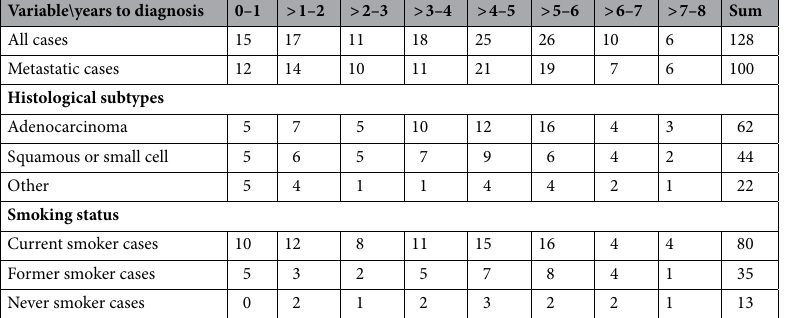
(Table S4). The gene with the lowest p-value for a non-linear trend in the absolute case–control differences in gene expression according to time to diagnosis in cases was FGFR3 (Fig. S5), which was also among the genes with the lowest p-values when restricting the analyses to cases with metastasis and their matched controls. The magnitude and direction of the spline coefficients were not consistent among the genes with the lowest p-values. Gene-wise assessments of differential expression among cases and contro ls .